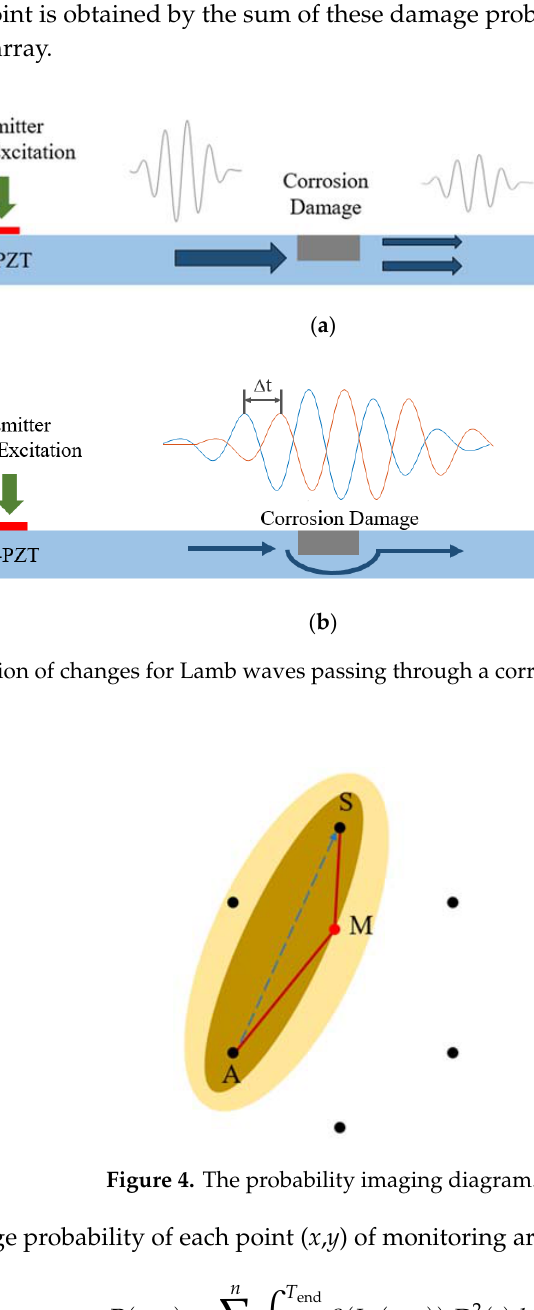
Figure 4. The probability imaging diagram.